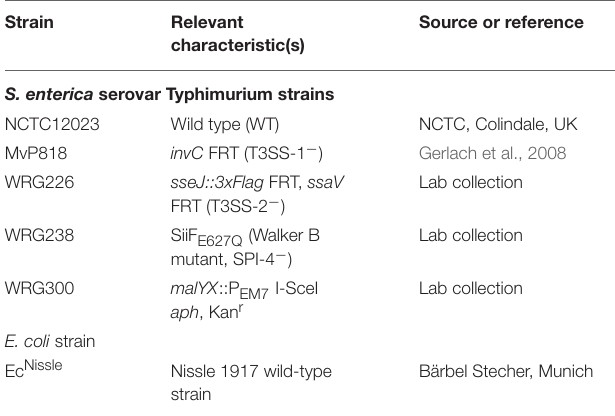
TABLE 1 | Bacterial strains used in this